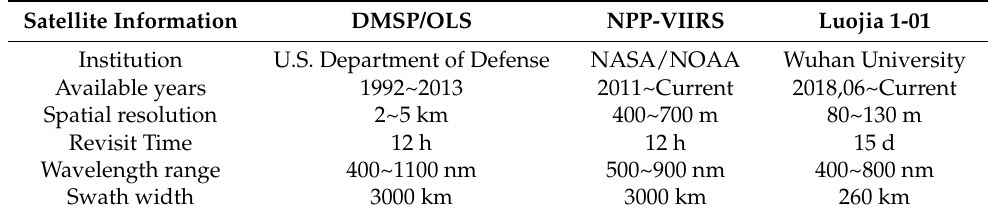
Table 1. The comparisons between Luojia 1-01 satellite and the other two nighttime light satellites DMSP/OLS and